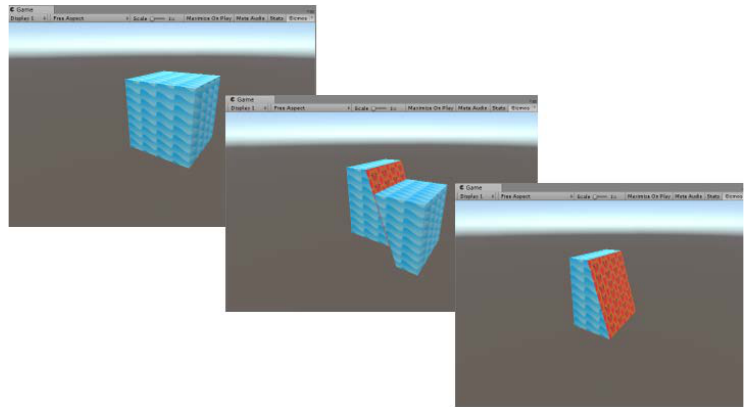
Figure 3. Example of cutting of a cube in Mixed Reality.